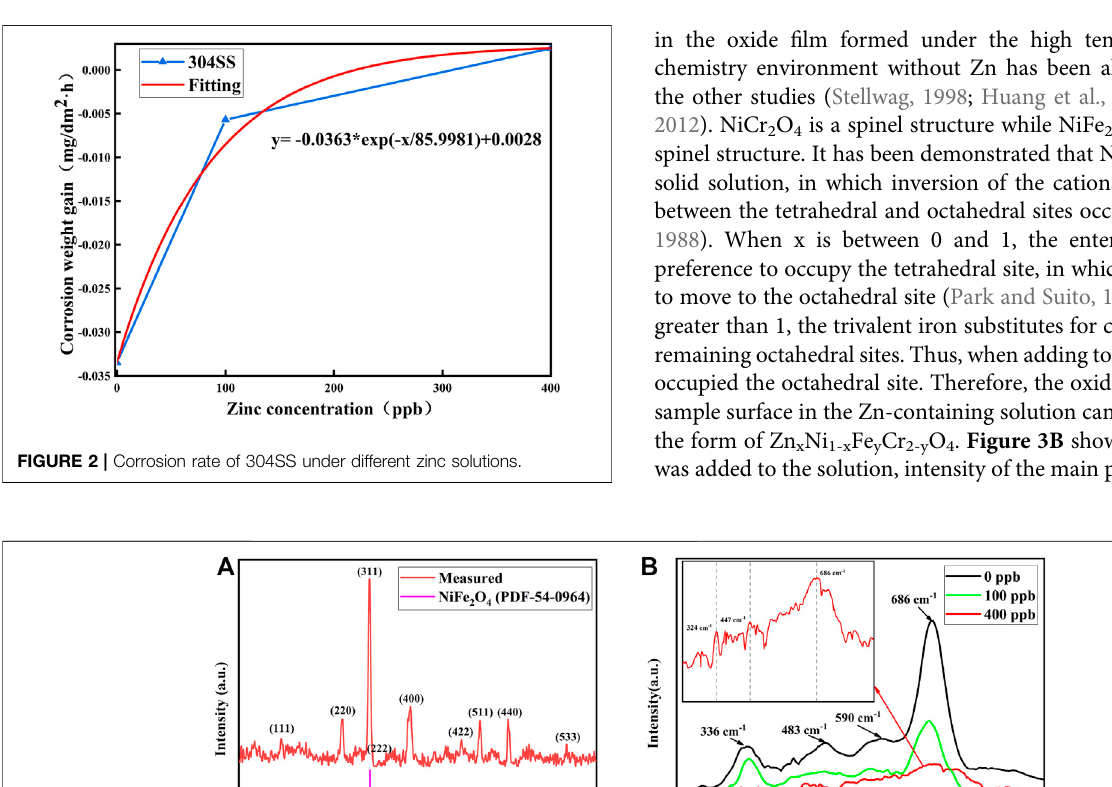
Frontiers in Materials |